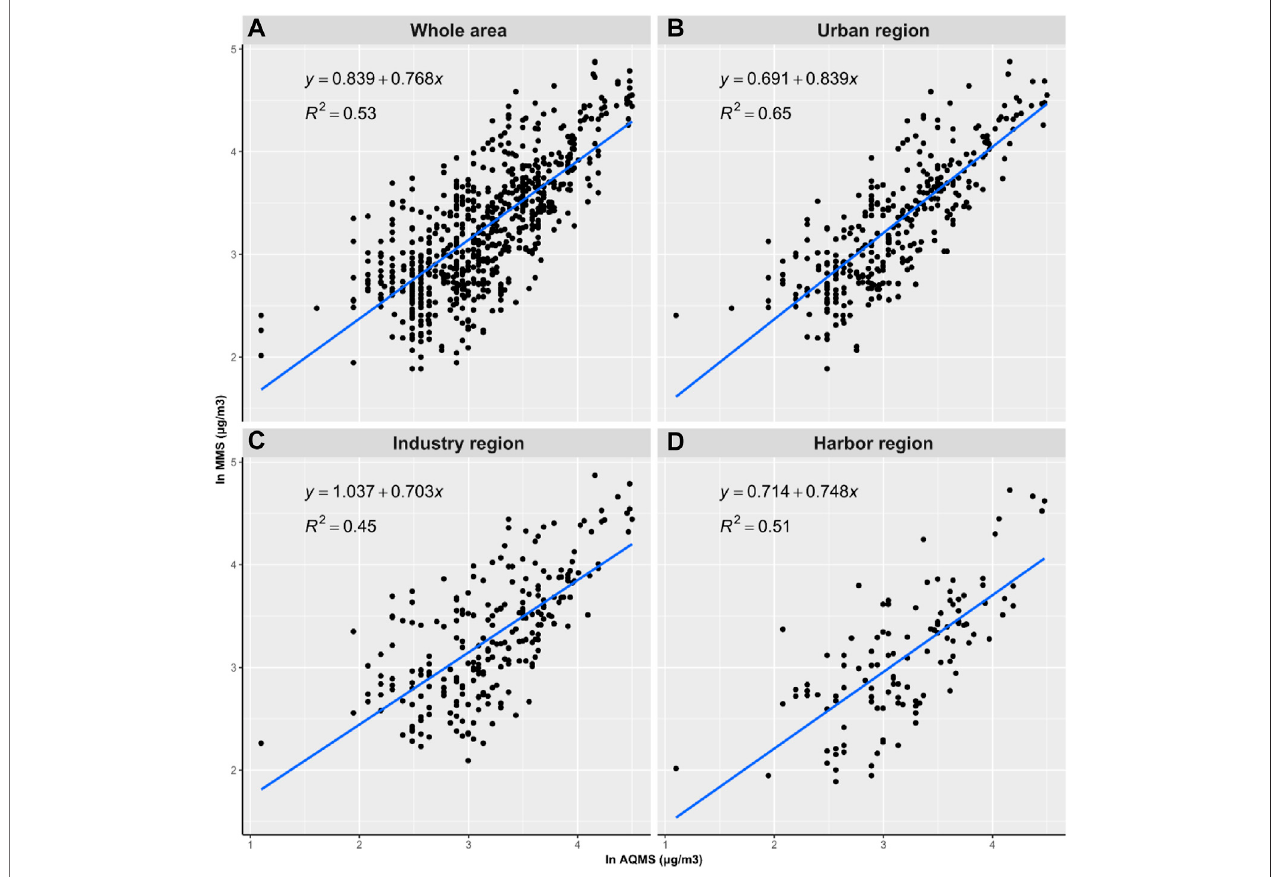
FIGURE 3 | Scatter plots of the MMS and AQMS for the (A) whole area, (B) urban region, (C) industry region, and (D) harbor